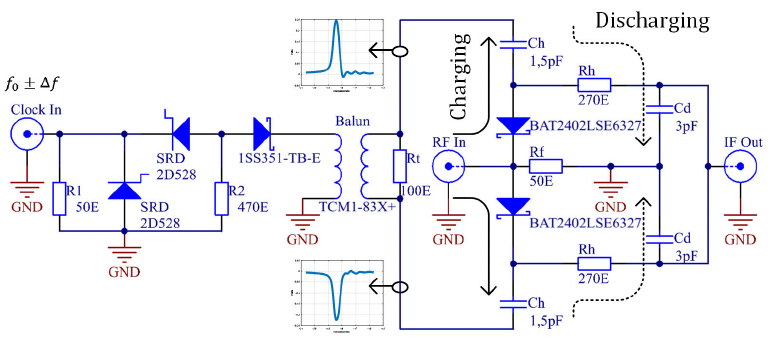
Figure 5. Schematic of the proposed sampling mixer. Left from the balun is the pulse generator part from the previous section. After the balun, which split the pulse from the generator into opposite pulses, is a sampling bridge with two diodes. The graphs present measured pulses at the balun’s output.